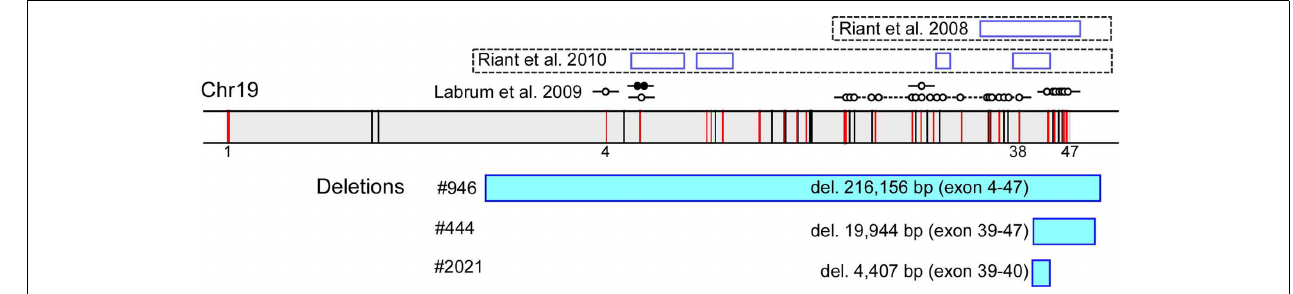
missing MLPA probes in the patients, labeled with the sizes and deleted exons.The open rectangles above the genomic structure of CACNA1A represent previously described deletions, with established boundaries, in five unrelated kindreds with EA2 (Riant et al., 2008, 2010), along with additional instances of genomic rearrangements without breakpoint ascertainment by Labrum et al., 2009; open circle – missing MLPA probe; closed circle – duplicated MLPA probe.